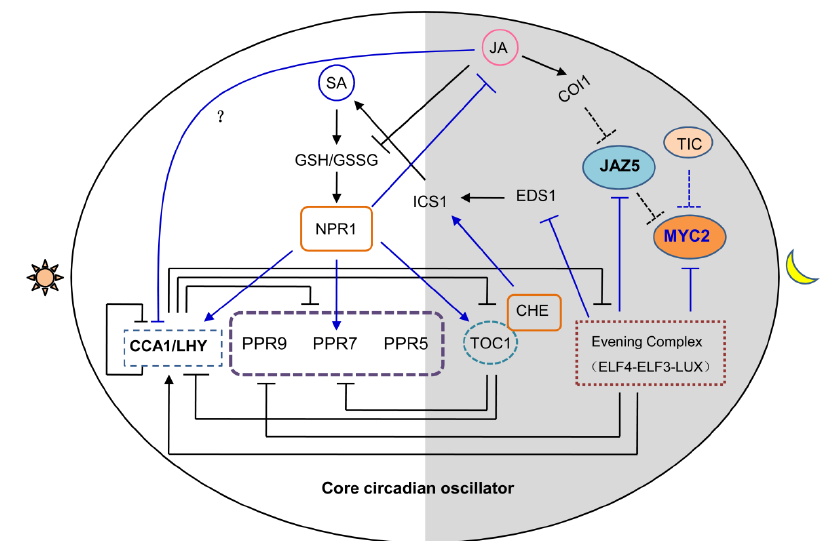
Figure 3. A proposed model for crosstalks between circadian clock and JA pathway in Arabidopsis